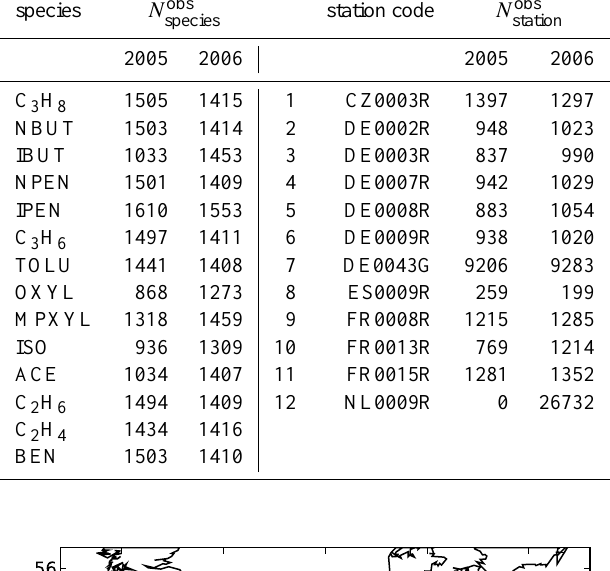
Forecast (ECMWF), delivered in 60 vertical levels and ) and species ). The num- station